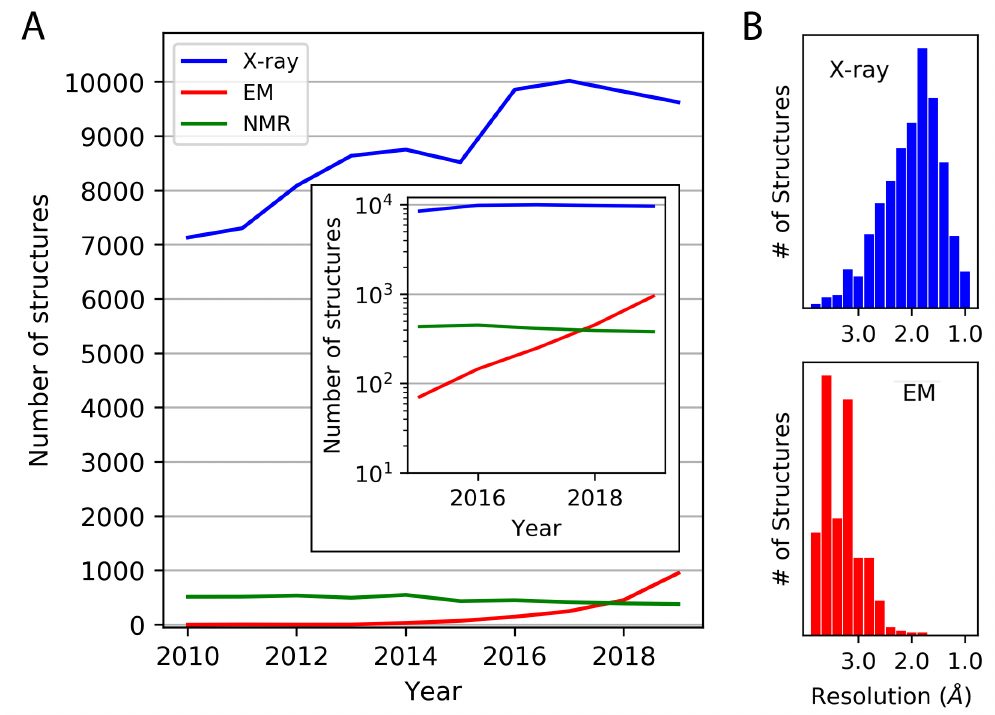
Figure 1. Deposition of atomic or near-atomic-resolution structures in the Protein Data Bank according to different experimental methods. ( A ) The number of structures deposited annually is shown between 2010 and the end of 2019, based on X-ray diffraction, cryo- electron microscopy (EM), and NMR methods. A sub-4 Å resolution criterion was imposed (for X-ray and EM). The inset shows the depositions since 2015 on a logarithmic scale. ( B ) The same set of structures are broken down by resolution. Those based on EM do not include those determined by electron diffraction methods (see Figure 4). This figure is an original image created by the authors for this